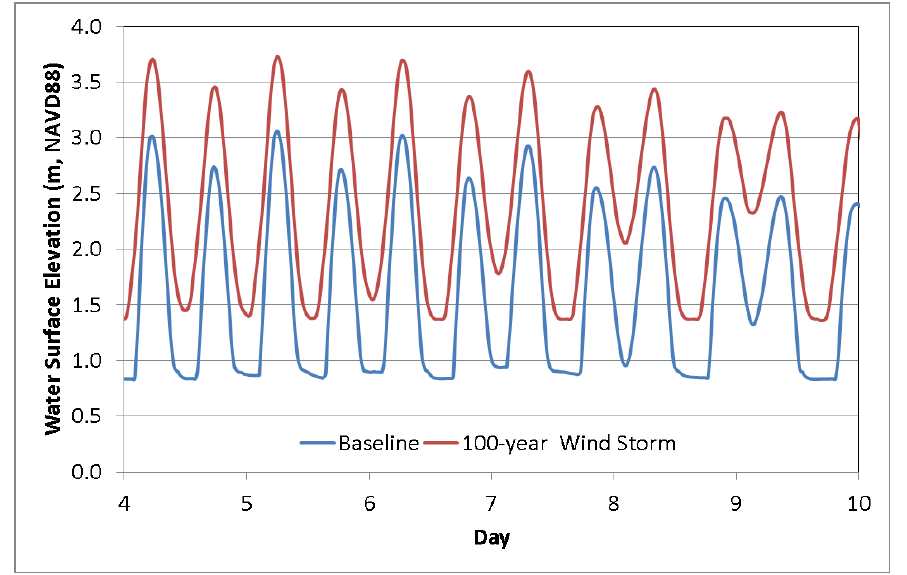
Figure 10. Comparison of water-surface elevations at the Skagit Bay front between baseline and restoration alternative with a 100-year wind